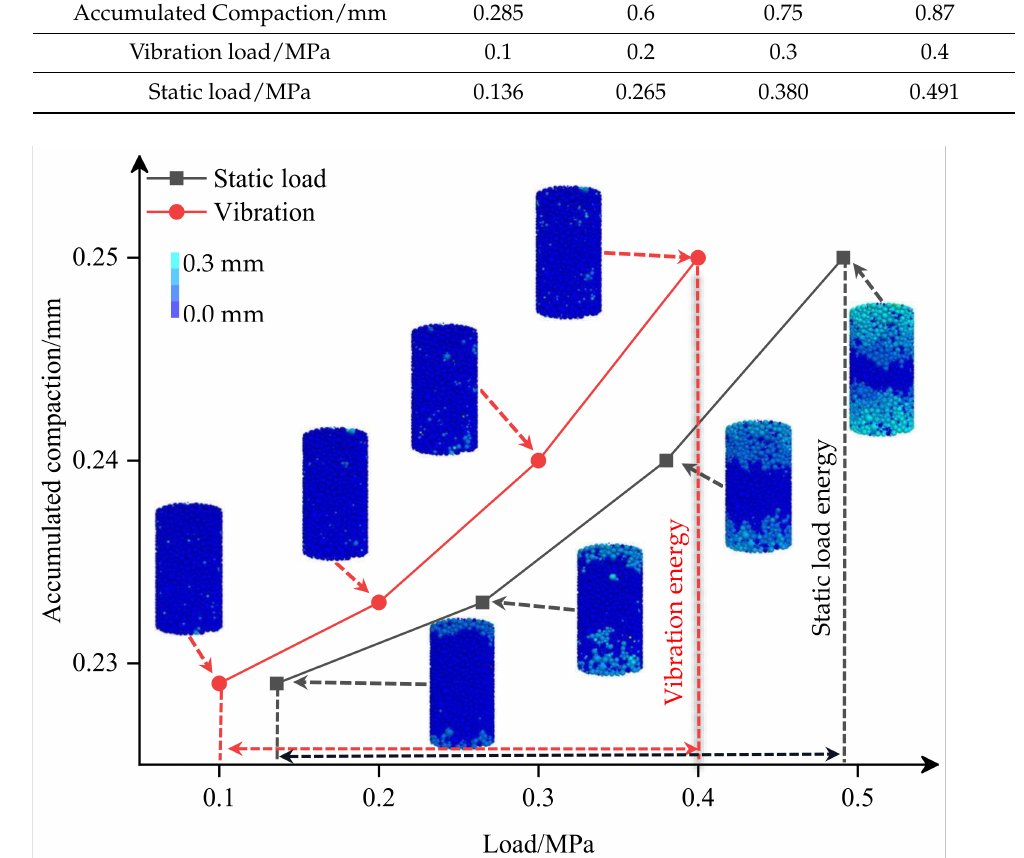
Figure 9. Comparison diagram of vibration and static loading (x-axis shows the load, y-axis shows the compaction